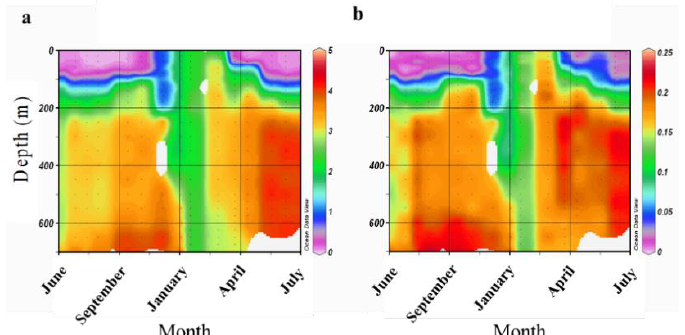
Figure 4. Nutrient variations measured in 2007–2008 at an open water site in the Gulf of Aqaba (northern Red Sea, N 29 ◦ 30.211’ E 34 ◦ 55.068’) throughout the survey. ( a ): Total Oxidized Nitrogen (TON) (micromole / l) and ( b ): Phosphates (PO 4 ) (micromole / l). The data was obtained by the Israeli national monitoring program and processed by Ocean Data View (ODV) software.